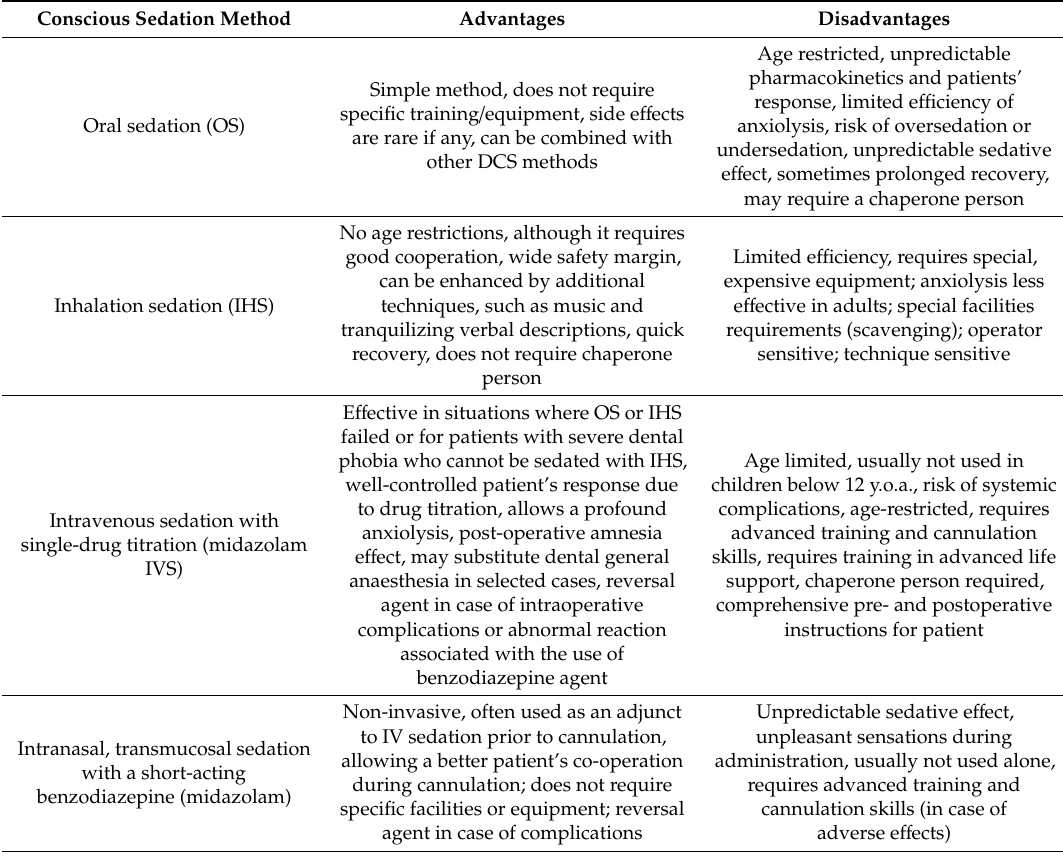
Table 1. Comparison of the main advantages and disadvantages of various dental conscious sedation (DCS) techniques used in dental care